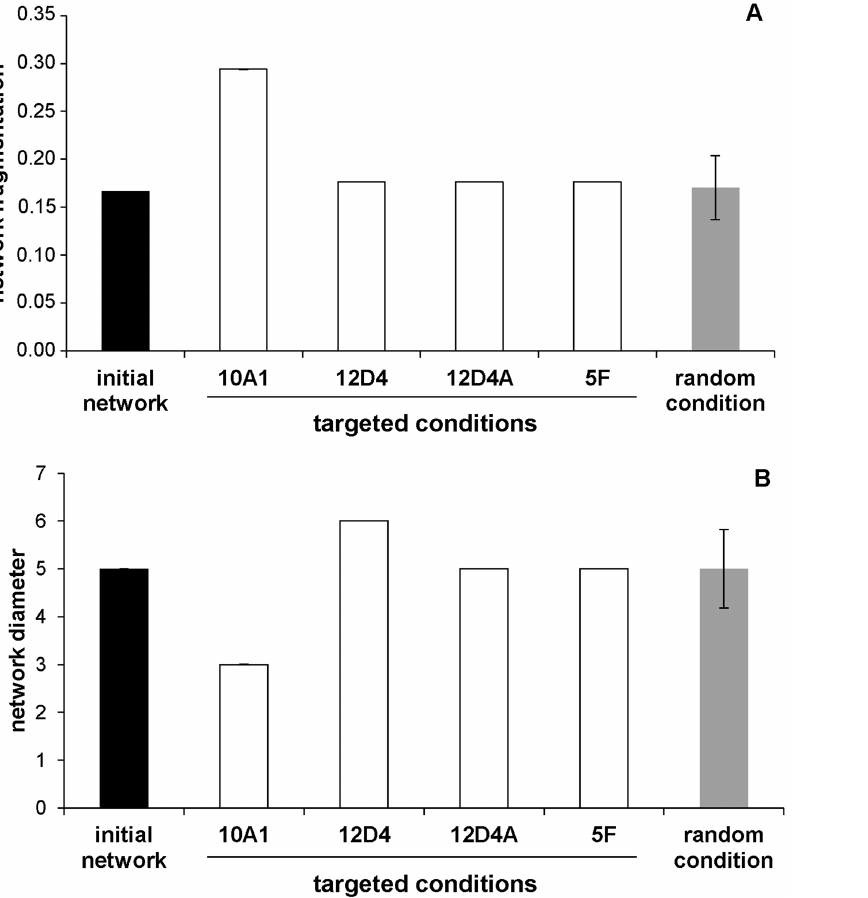
Figure 4. Changes in network characteristics after the removal of central individuals (targeted condition) and randomly chosen individuals (random condition). (A) Network fragmentation, and (B) network diameter. In all figures, dark columns represent the initial network, grey columns represent random condition and white columns represent targeted condition.